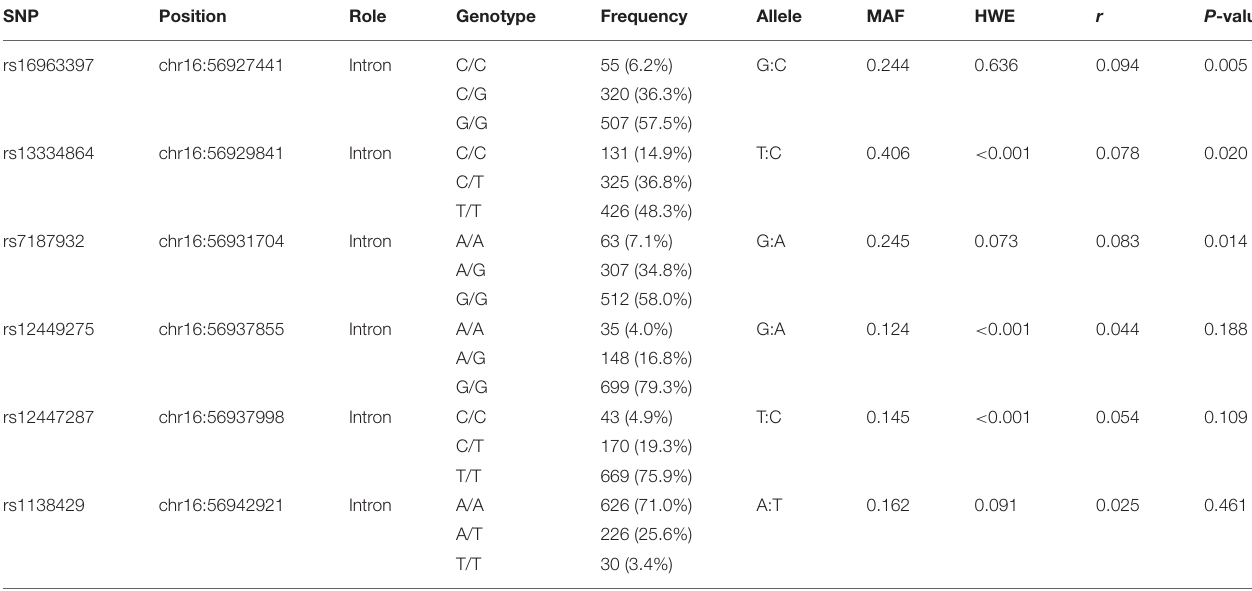
TABLE 2 | Association of individual SLC12A3 gene variants and estimated glomerular filtration rate (cohort 1). SNP Position Role Genotype Frequency Allele